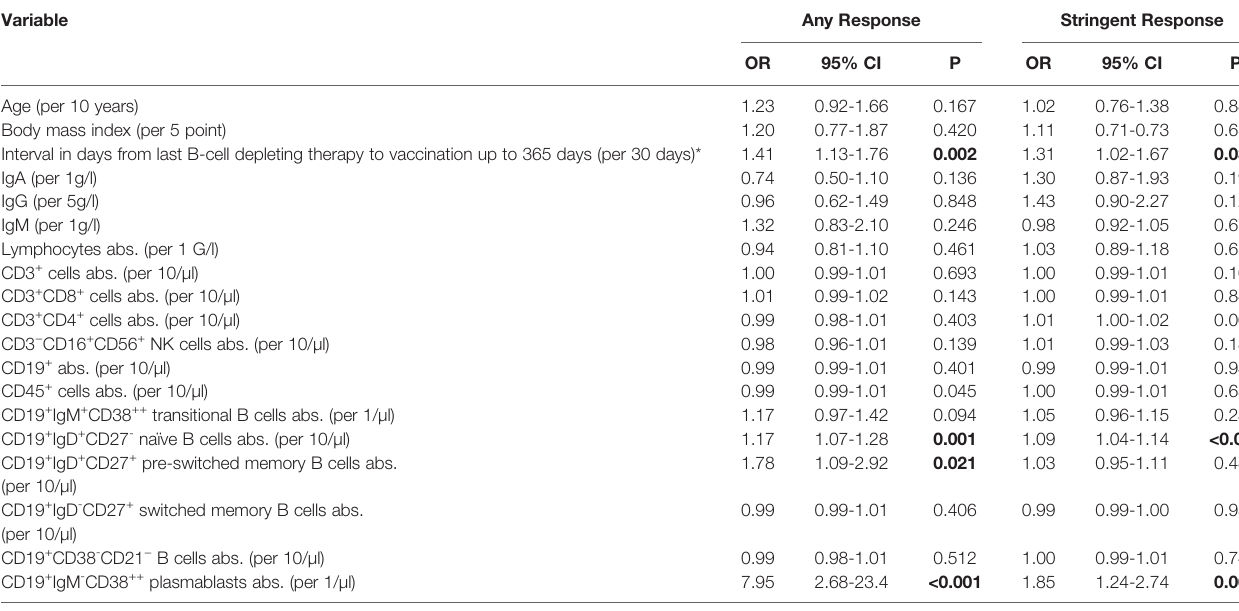
TABLE 4 | Univariate linear regression analysis to test the association of variables with vaccination response determined by the Roche anti-SARS-CoV-2 S assay in the immunode fi cient cohort.